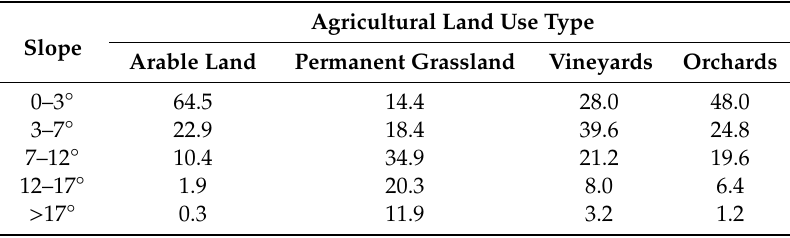
Table 6. Share of slope degree (%) in agricultural land use types in Slovakia.